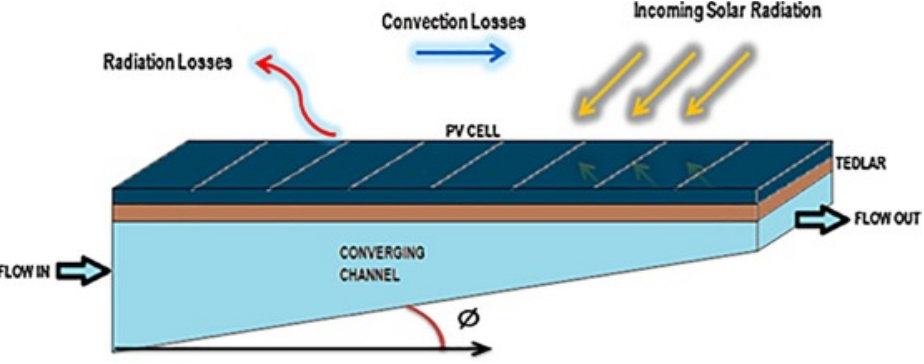
Figure 46. Converging channel used for PV cooling [179].